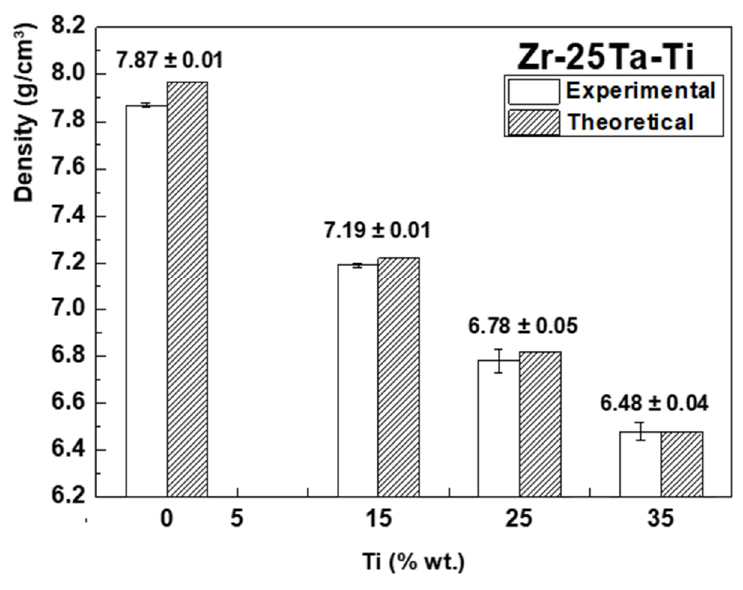
Figure 2. Density of the produced Zr-25Ta-xTi alloys as a function of titanium concentration.